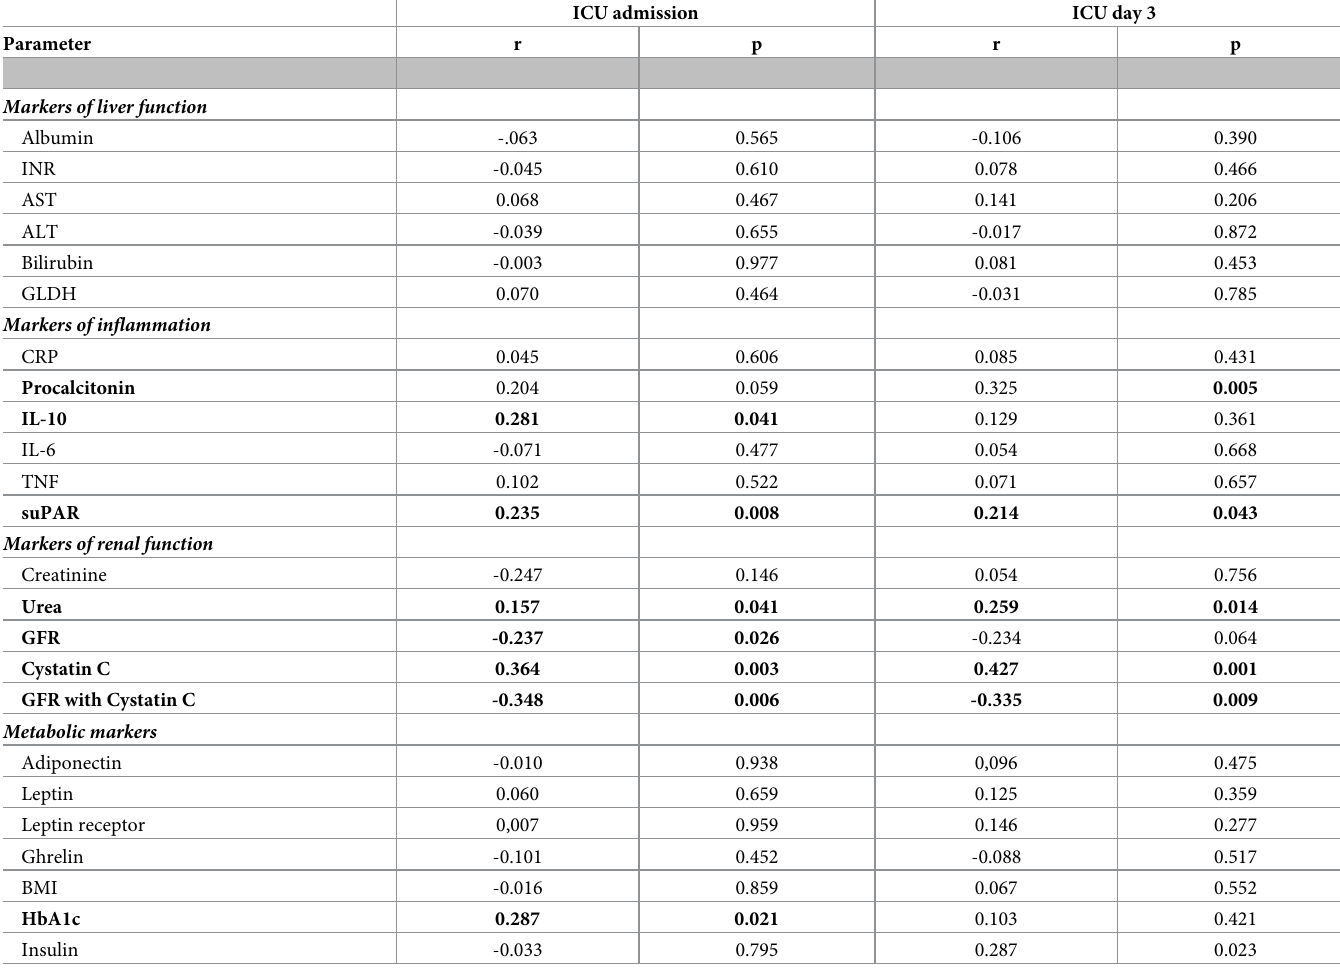
Table 2. Correlations of Kisspeptin serum concentrations and other laboratory markers at day of admission to the